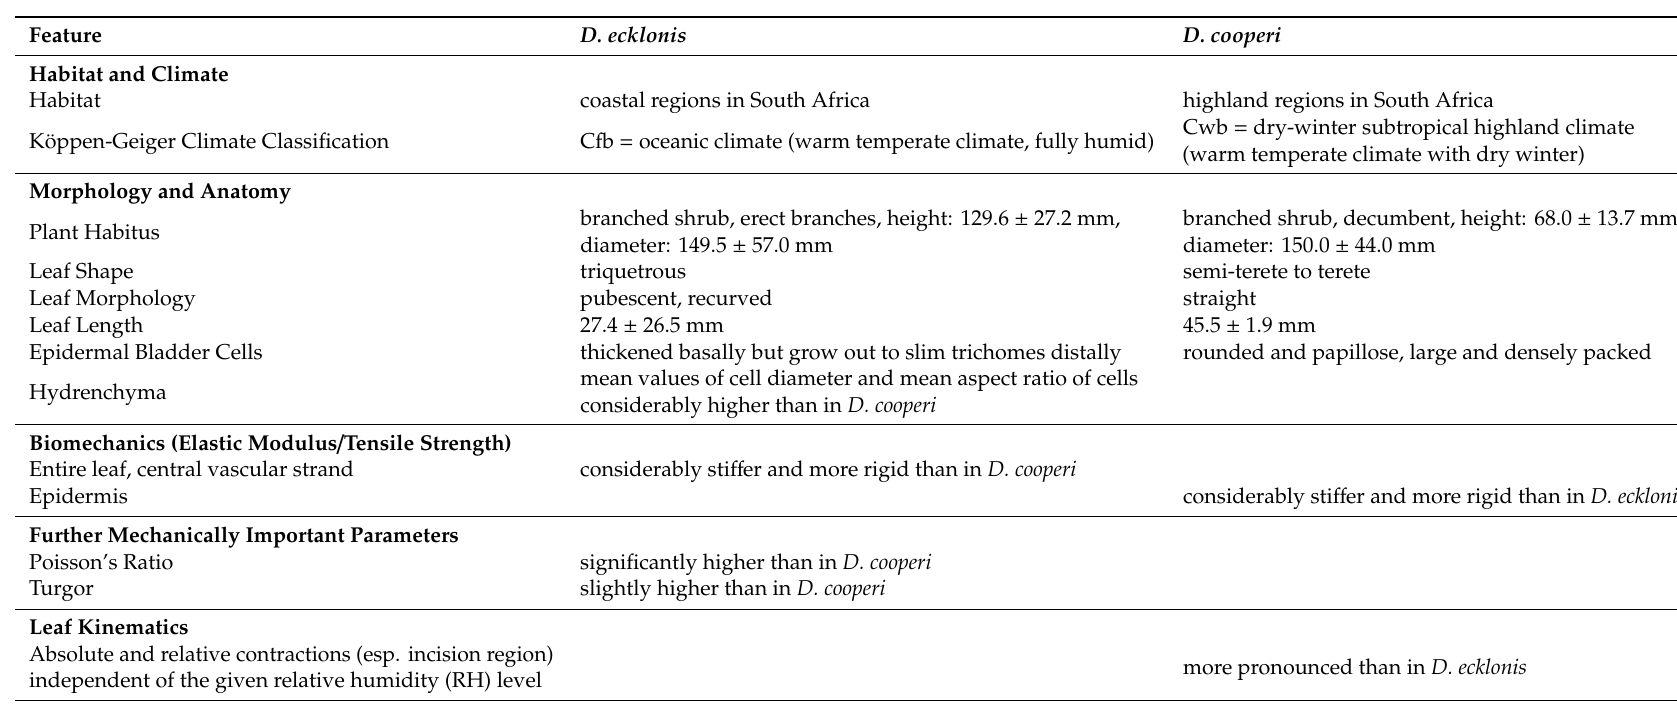
Table 3. Summary of species specific characteristics of D. ecklonis and D. cooperi